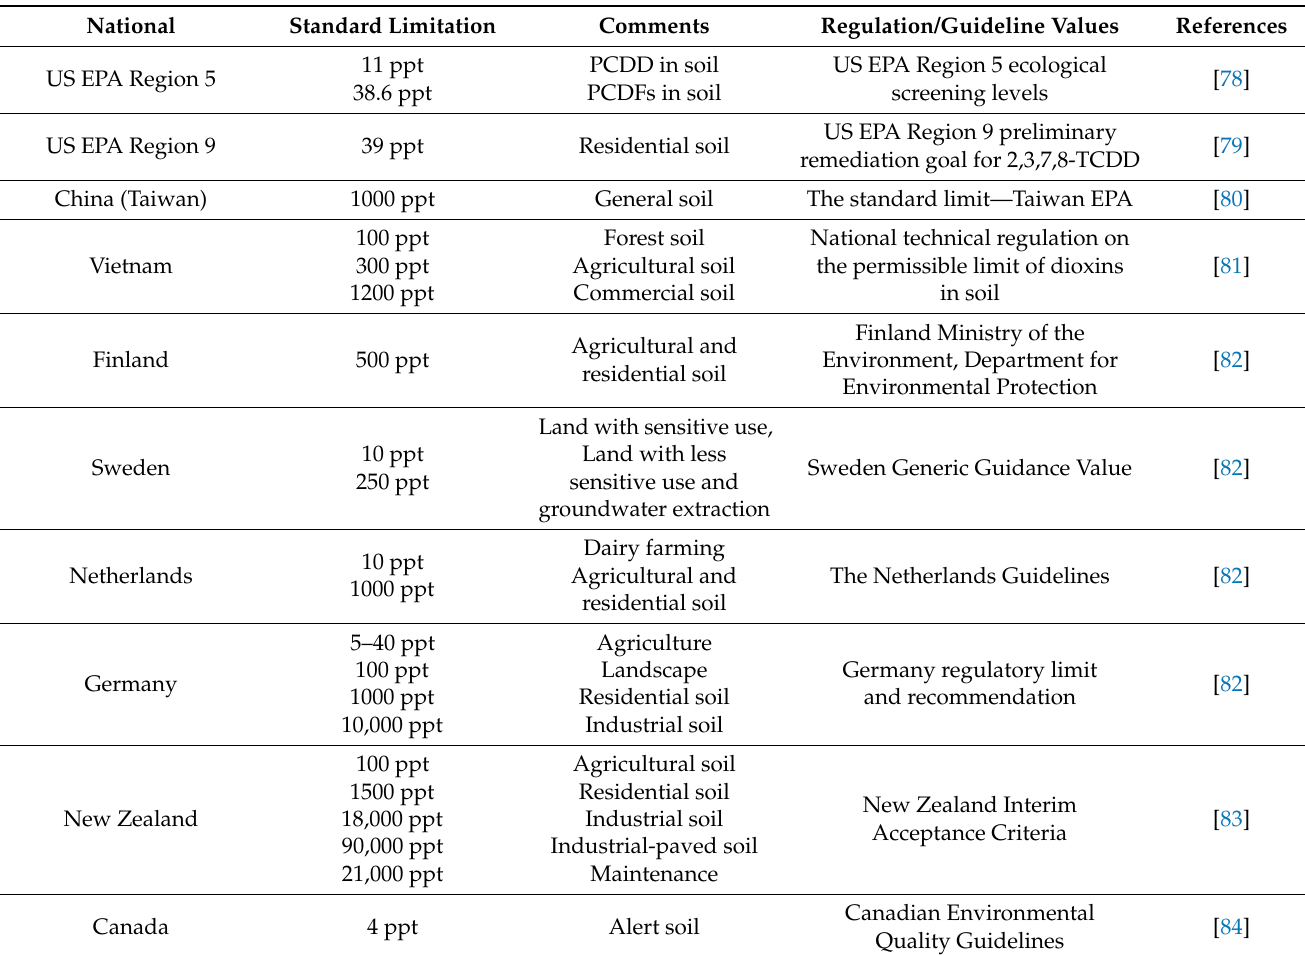
Table 3. Some standards limitations for PCDD/Fs (ppt TEQ) in different